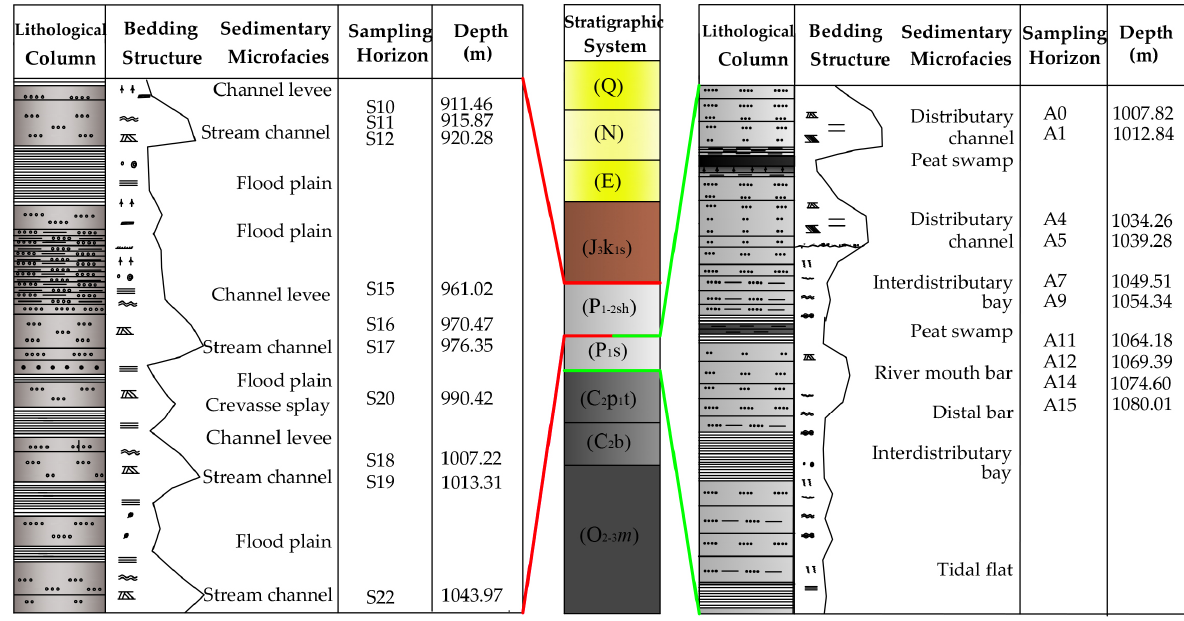
Figure 1. The sampling horizons and depths of the Jurassic sandstone collected from the Anju coal mine of the Southwest Shandong coalfield: The colored column on the left shows the overall strat- igraphic structure of the Southwest Shandong coalfield; The orange column on the right shows the stratigraphic texture of the Jurassic System (J 3 k 1 s) in detail.